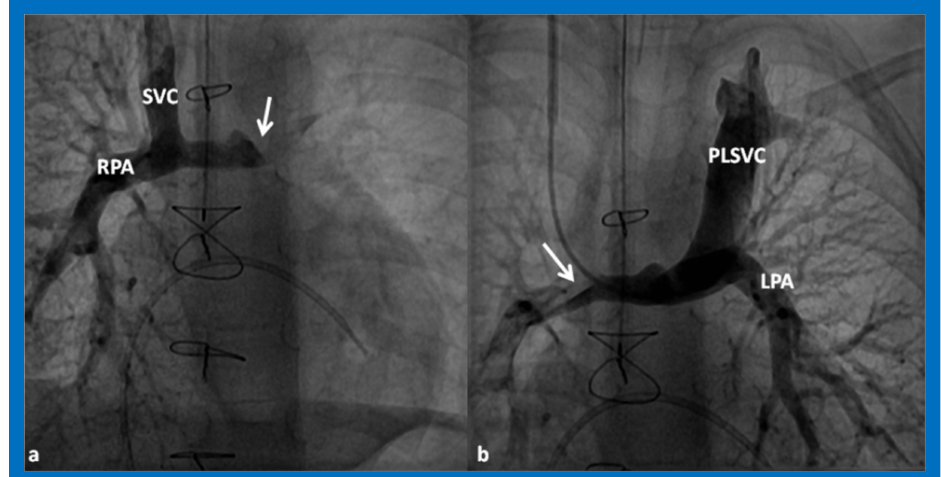
Figure 13. Selected cine-angiographic images demonstrating the bilateral bidirectional Glenn pro- cedure. ( a ) This is an angiogram with contrast injection into the right superior vena cava (SVC) illustrating rapid visualization of the right pulmonary artery (RPA). The unopacified blood from a persistent left superior vena cava (PLSVC) is shown with an arrow in “( a )”. ( b ). This is an angiogram from the PLSVC demonstrating rapid visualization of the left pulmonary artery (LPA). The unopaci- fied blood from the right SVC is shown with an arrow in “( b )”. These figures demonstrate flow of the contrast material from both the SVCs into the LPA and RPA, respectively, without